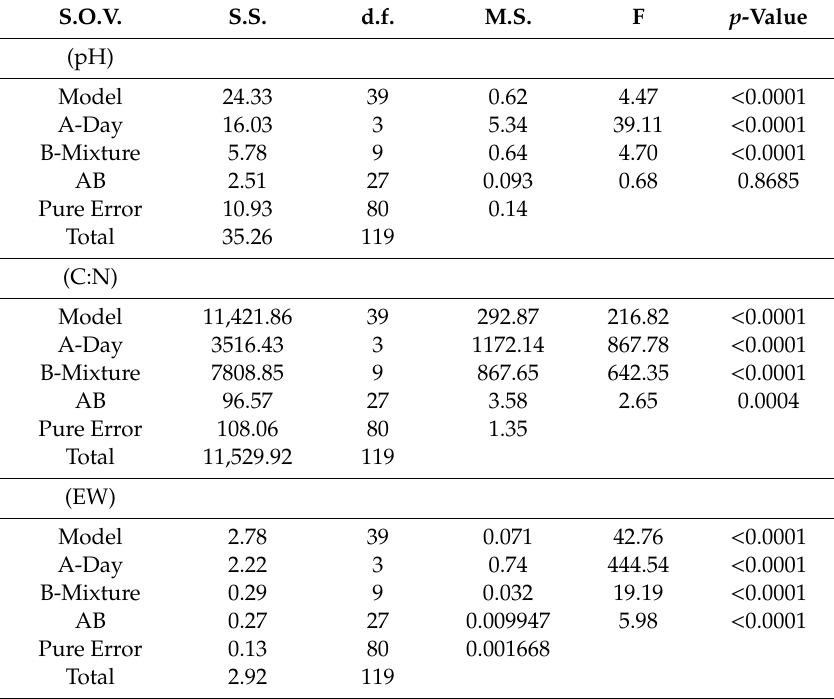
Table 1. The results of ANOVA for pH, C:N and earthworm (EW) values during the vermicomposting of di ff erent POME percentages in PPF ( Eudrilus eugeniae